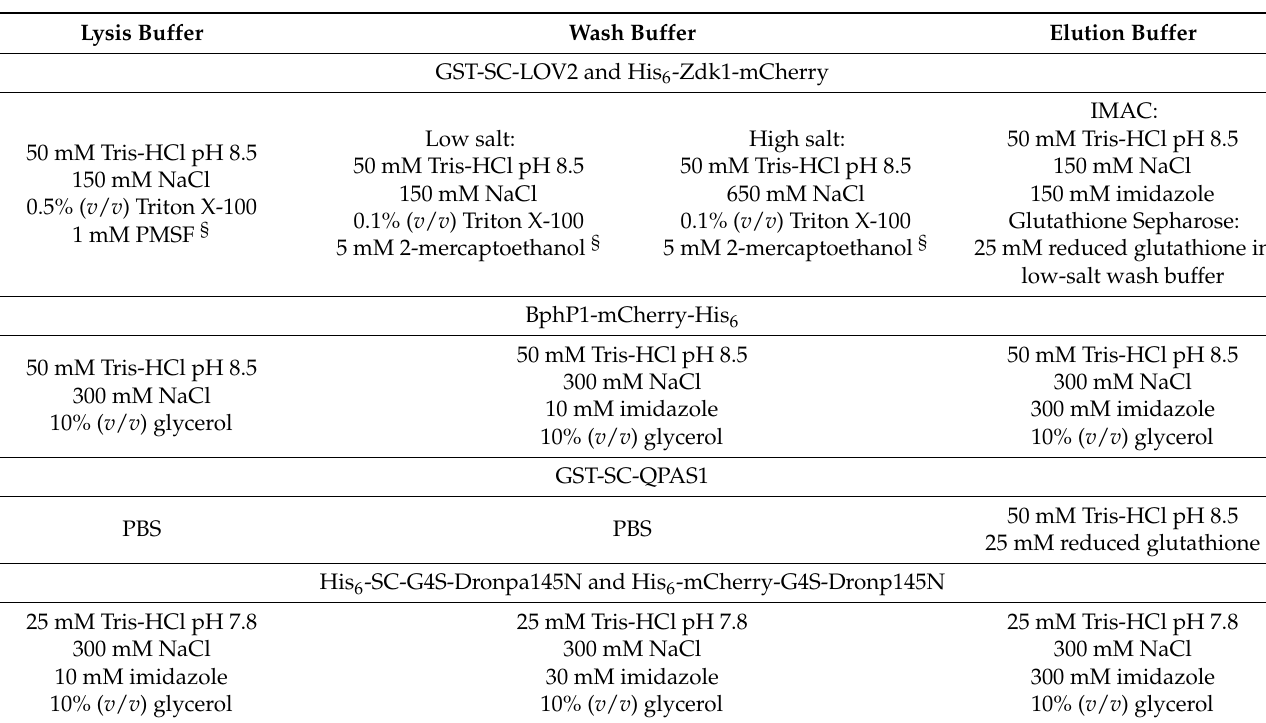
Table 2. Buffers for lysis, washing and elution during the purification of each protein component. The LOV2 and Zdk1 proteins were purified as previously described ([47]). For the Dronpa145N proteins, all cell disruption and purification steps were carried out in the dark or under red light (630 nm) as previously described (Zhou et al.,